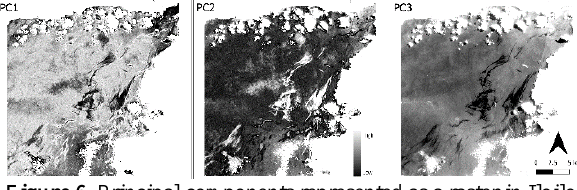
Figure 6. Principal components represented as a raster in Iloilo Straight. The explained variance ratios for PC1, PC2, and PC3 were 90%, 10%, and 1%, respectively.